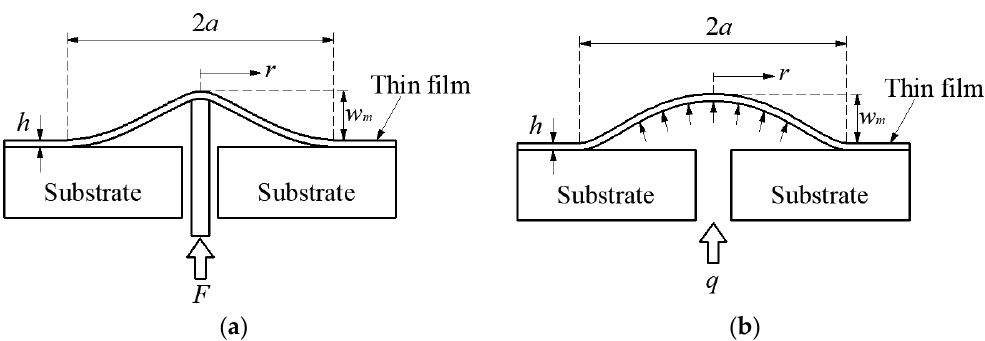
Figure 1. Sketch of the loading configurations for ( a ) shaft-loaded blister, ( b ) pressurized blister [9].